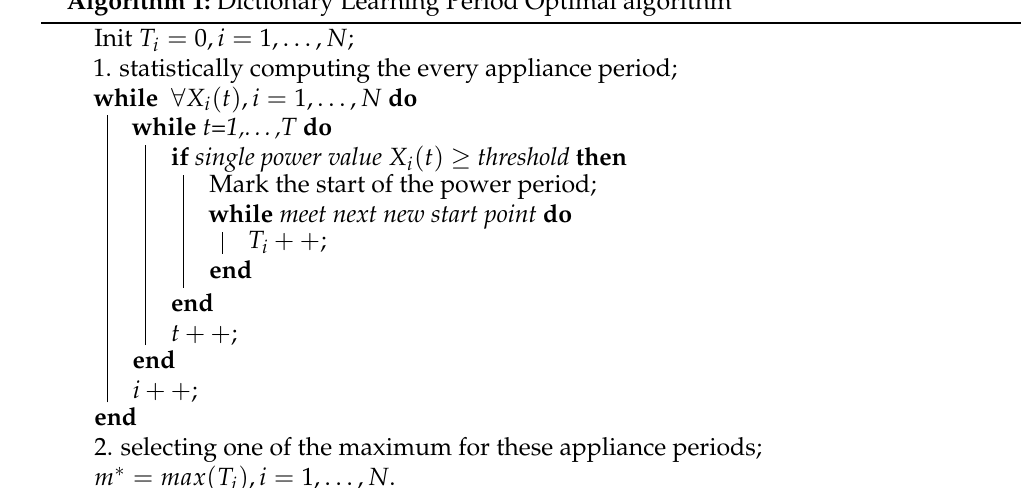
Algorithm 1: Dictionary Learning Period Optimal